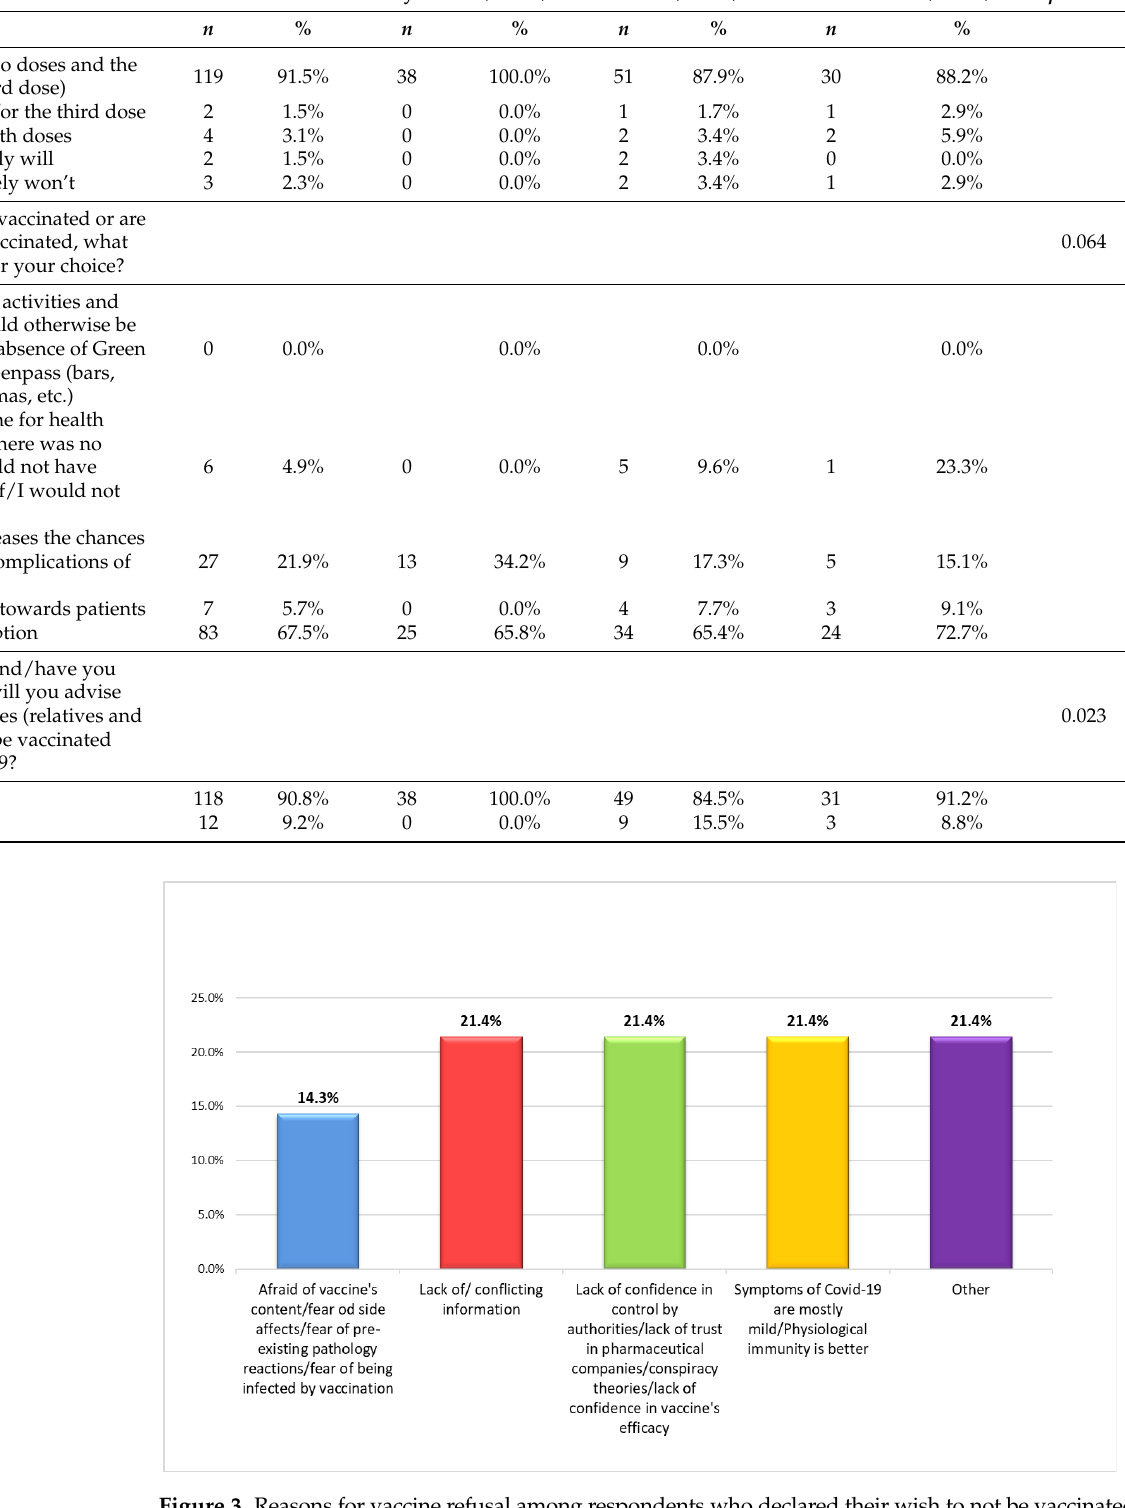
Figure 4. Main reasons for choosing to be vaccinated.